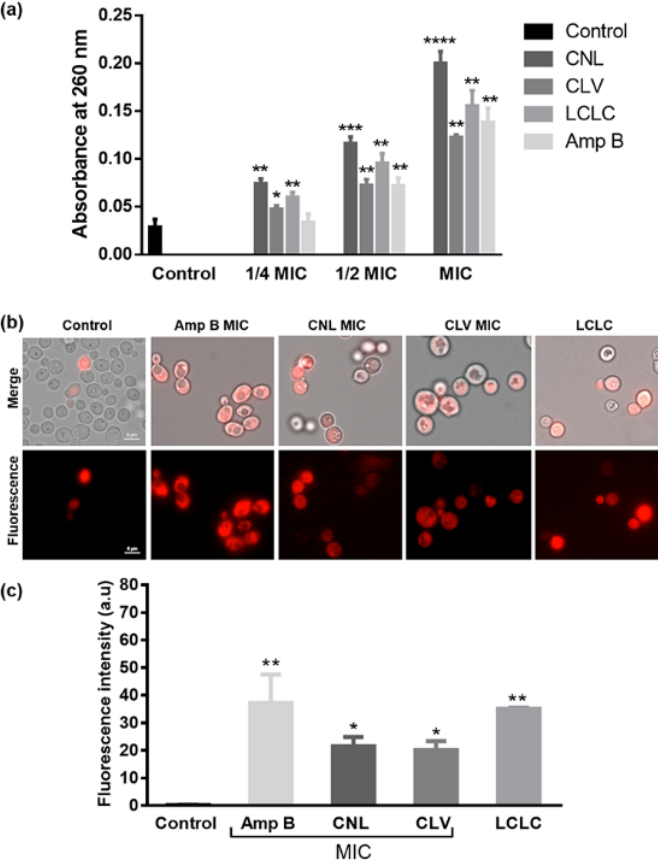
Figure 2. Membrane integrity assays of C. albicans RSY150 exposed to EOs. ( a ) CNL, CLV alone and together caused leaky membranes and subsequent cell death. ( b ) Representative merged bright-field/fluorescence (top) and fluorescence (bottom) images ( λ ex = 493 nm; λ em = 636 nm) and ( c ) bar graphs of treated Candida show significant PI uptake as compared to controls. Scale bars are 5 µm for controls and applicable to all images. Untreated cells served as a negative control, and those treated with Amp B were used for comparison. Asterisks indicate statistically significant differences (****, p < 0.0001; ***, p = 0.0002; **, p = 0.001 - 0.0012, and *, p = 0.0419) compared to the untreated controls.